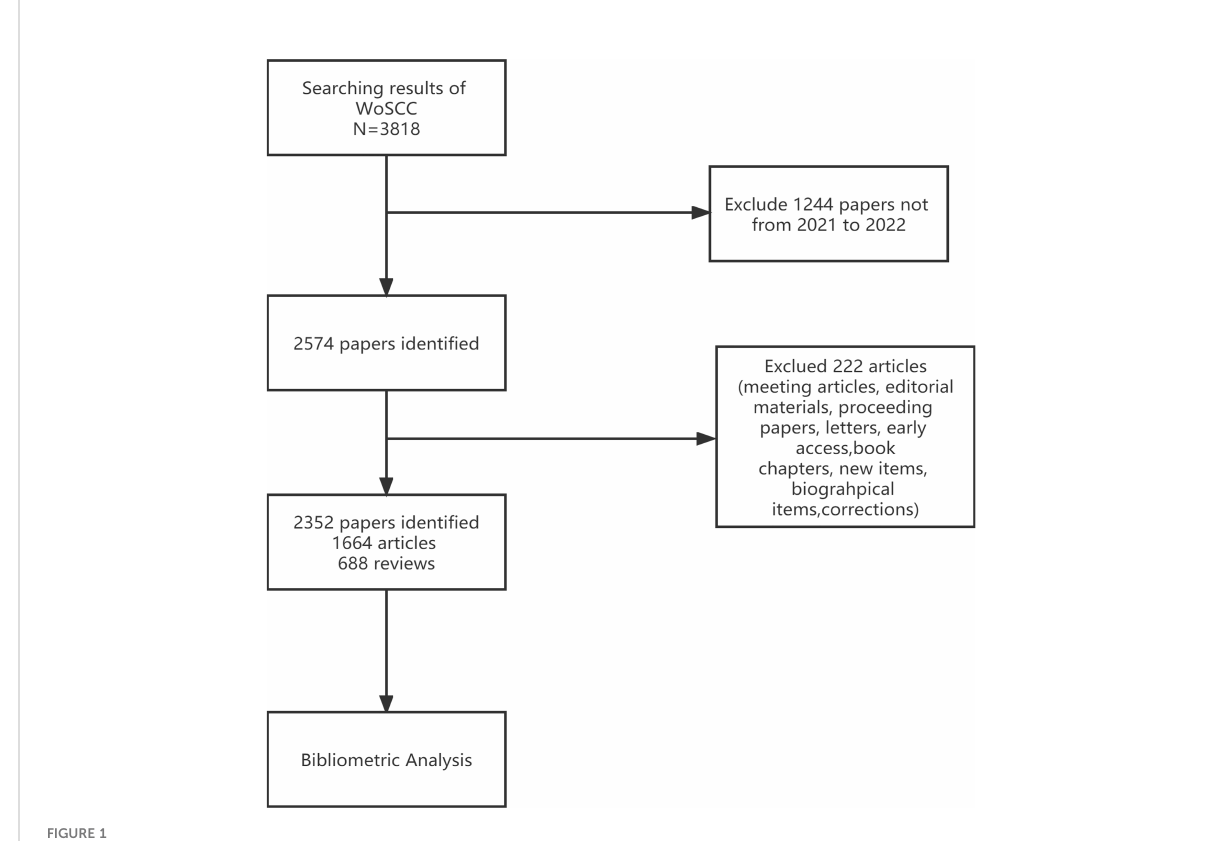
FIGURE 1 Flow chart of search strategy in this